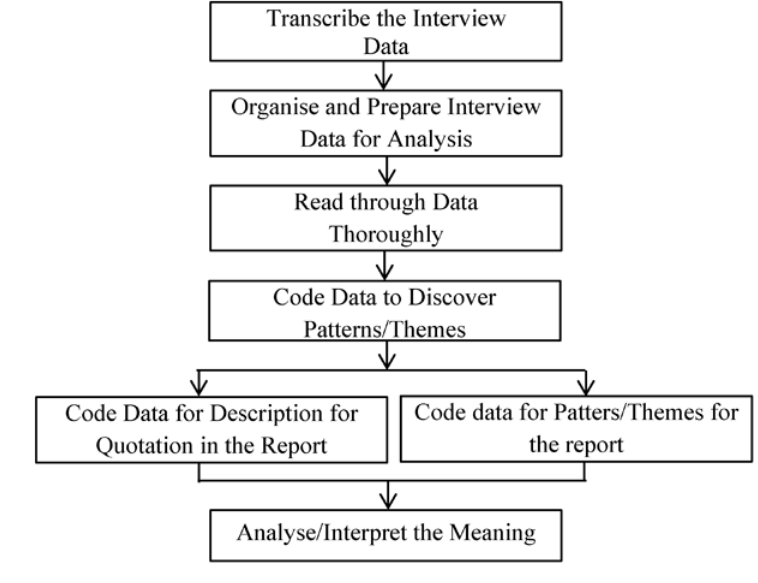
Semi-structured interview transcription and coding